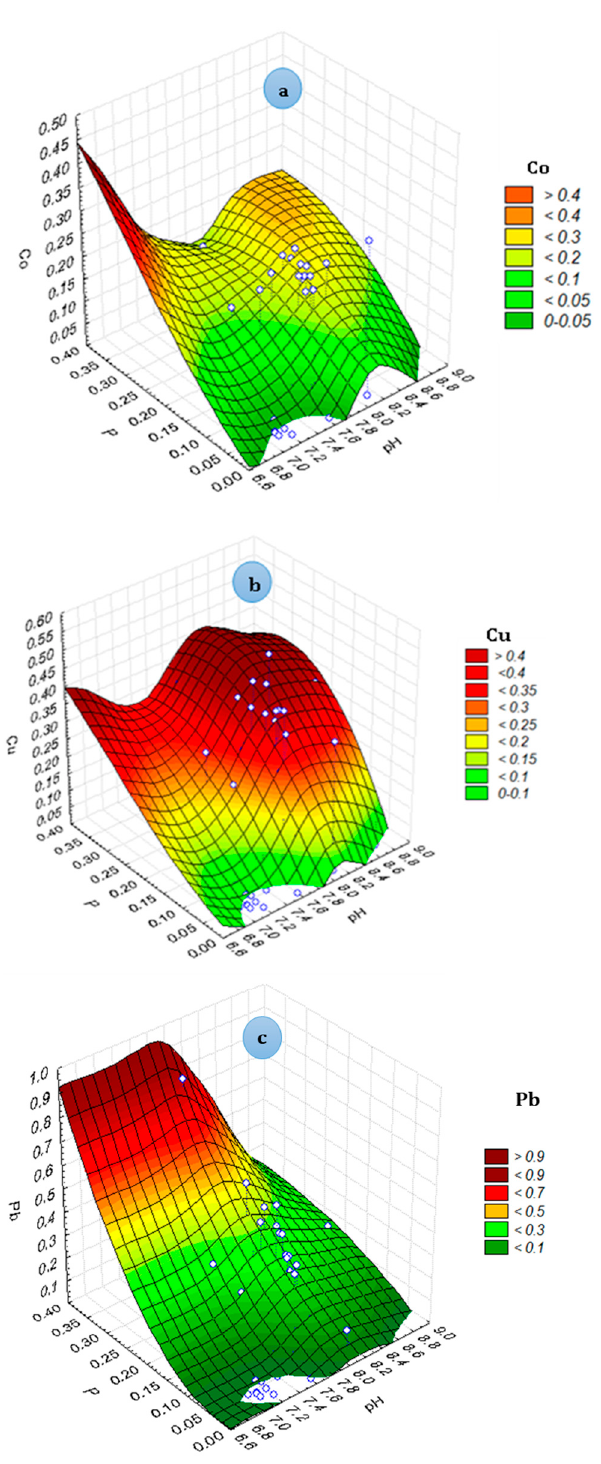
Figure 4. 3D surface plot of Co ( a ), Cu ( b ) and Pb ( c ) versus pH and P showing a three-dimensional functional relationship between designated dependent variable (Z = Co, Cu and Pb) and two inde- pendent variables (X = pH, Y = P).